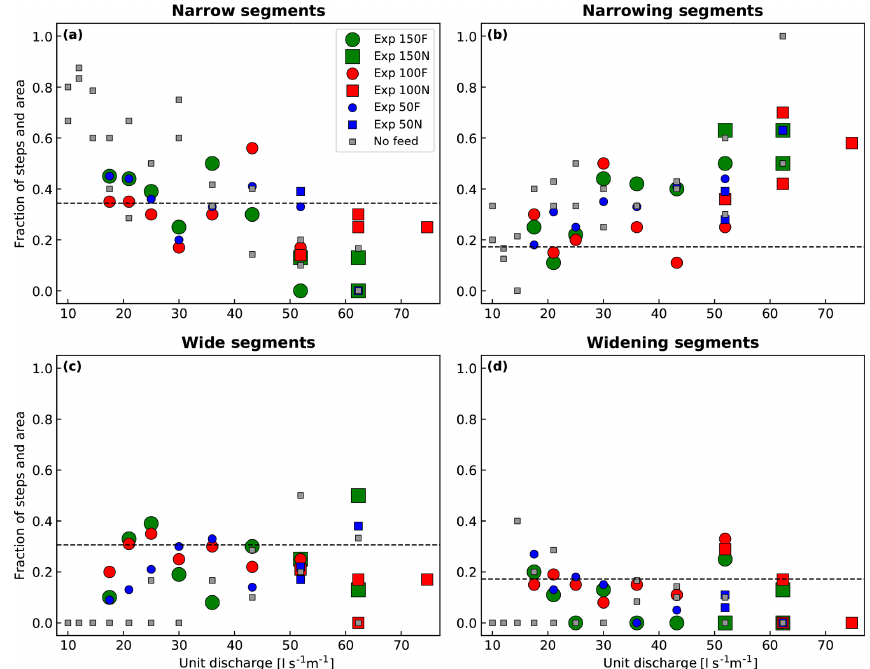
Figure 6. Fraction of steps in the feed and no-feed experiments at the end of each hour in (a) narrow segments, (b) narrowing segments, (c) wide segments, and (d) widening segments. Portions of experiments with sediment feed are shown with circles, while portions without sediment feed are shown with squares. The area fraction is shown with a dashed black line for comparison. Markers plotting above the dashed line indicate steps are more likely to occur in these segments; markers plotting below that line indicate instead that steps are less likely to occur in these segments.